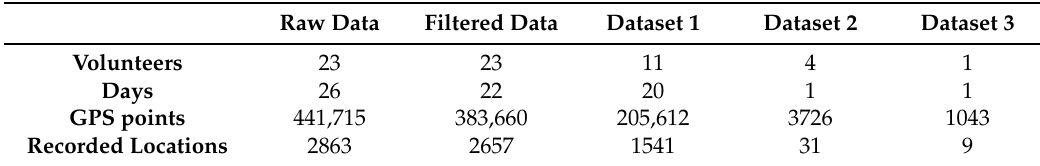
Table 1. Details of different datasets.